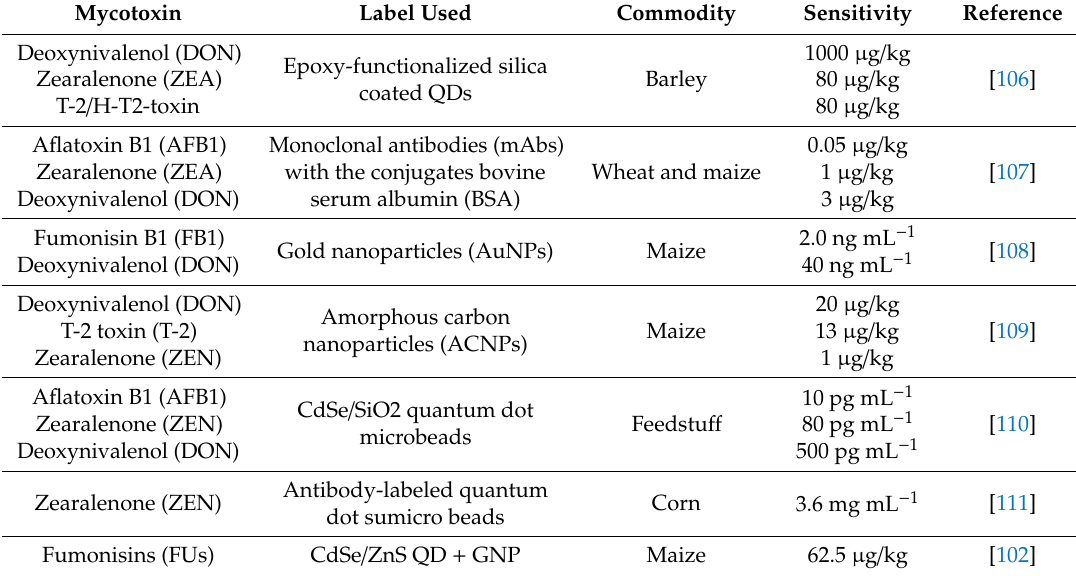
Table 4. Some examples of lateral-flow devices for detection and quantification of mycotoxins. Mycotoxin Label Used Commodity Sensitivity